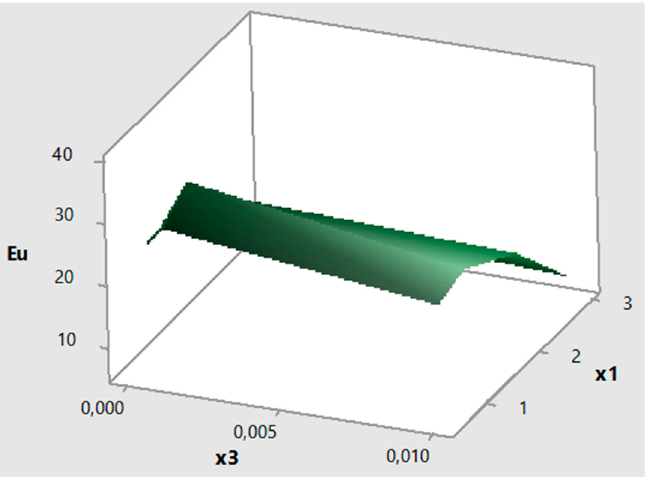
Figure 11. Surface plot of E u 50 vs. x1 and x3.